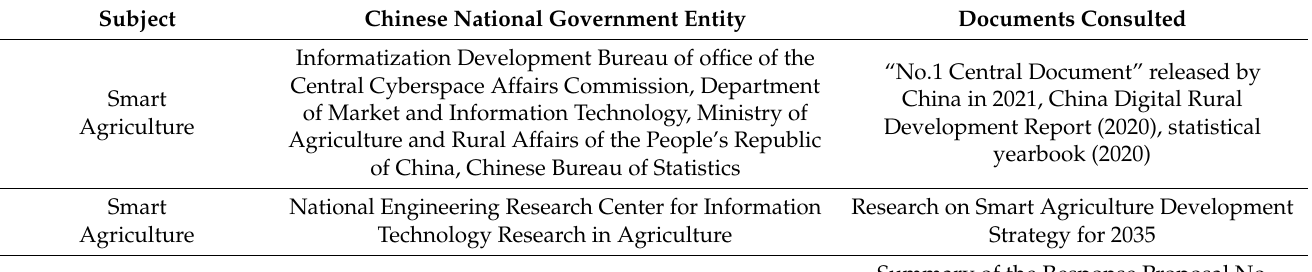
Table 1. Government documents